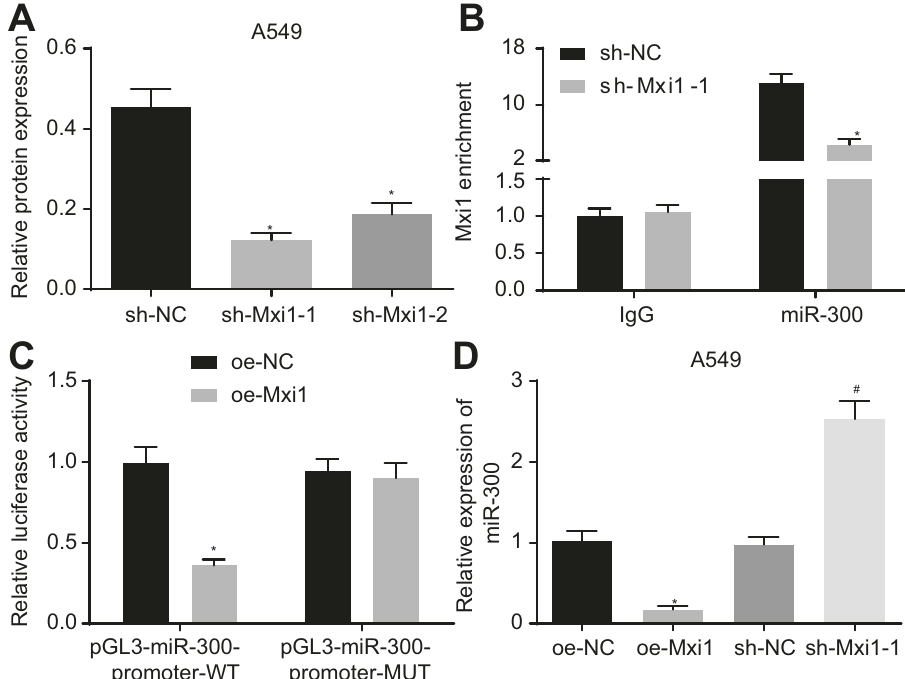
Fig. 3 Mxi1 elevation represses miR-300 expression at the transcription level in lung cancer cells. A Western blot analysis detecting the protein expression of Mxi1 in A549 cells. * p < 0.05, vs. sh-NC. B Result of ChIP assay evaluating the enrichment of Mxi1 at the promoter region of miR-300. * p < 0.05, vs. sh-NC. C Result of dual reporter gene assay detecting the interaction between Mxi1 and miR-300 promoter region. * p < 0.05, vs. oe-NC. D Result of RT-qPCR detecting the expression of miR-300 under indicated conditions. * p < 0.05, vs. oe-NC; # p < 0.05, sh-NC. Cell experiments were conducted three times